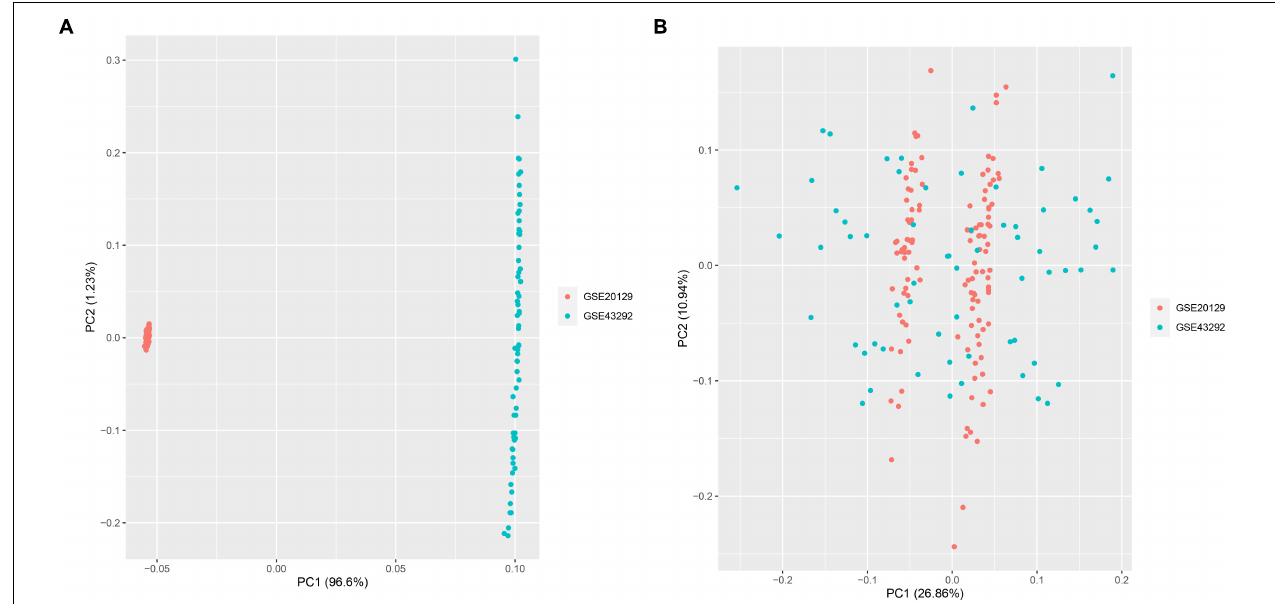
FIGURE 2 | Principal component analysis (PCA) for the two datasets (GSE20129 and GSE43292) before (A) and after merge (B) .